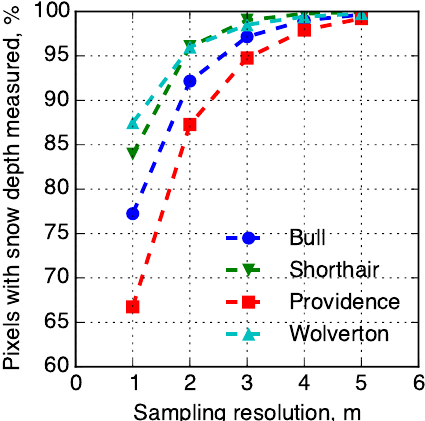
Figure 5. Sensitivity of the percent of pixels with snow depth mea- sured to the sampling resolution used in processing the lidar point cloud at each